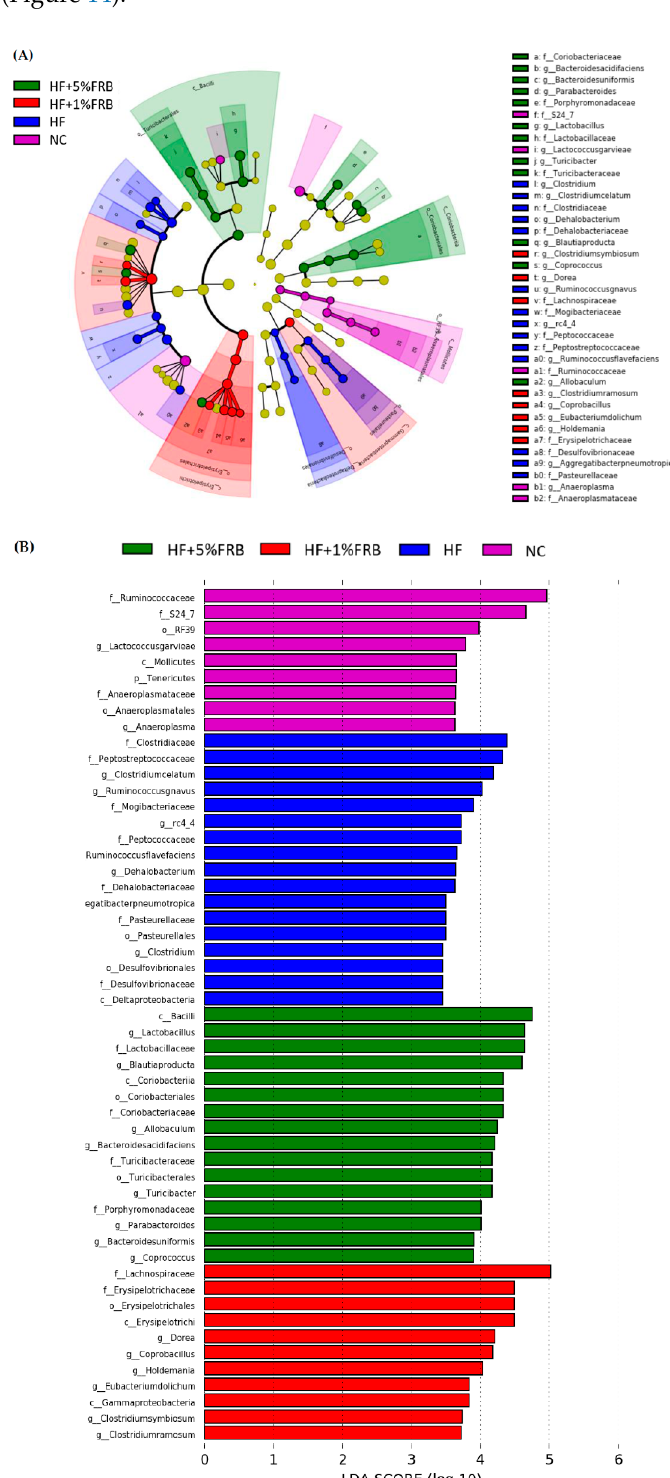
Figure 11. Effects of the water extract of fermented rice bran (FRB) on taxonomies of fecal microbiotic compositions in aged rats with high-fat (HF) diet feeding. ( A ) A linear discriminant analysis of the effect size (LEfSe) of the most significant abundance differences in the fecal microbiota among all groups ( n = 5). ( B ) Bacteria meeting the LDA threshold ( ≥ 2) differed among all groups ( n =